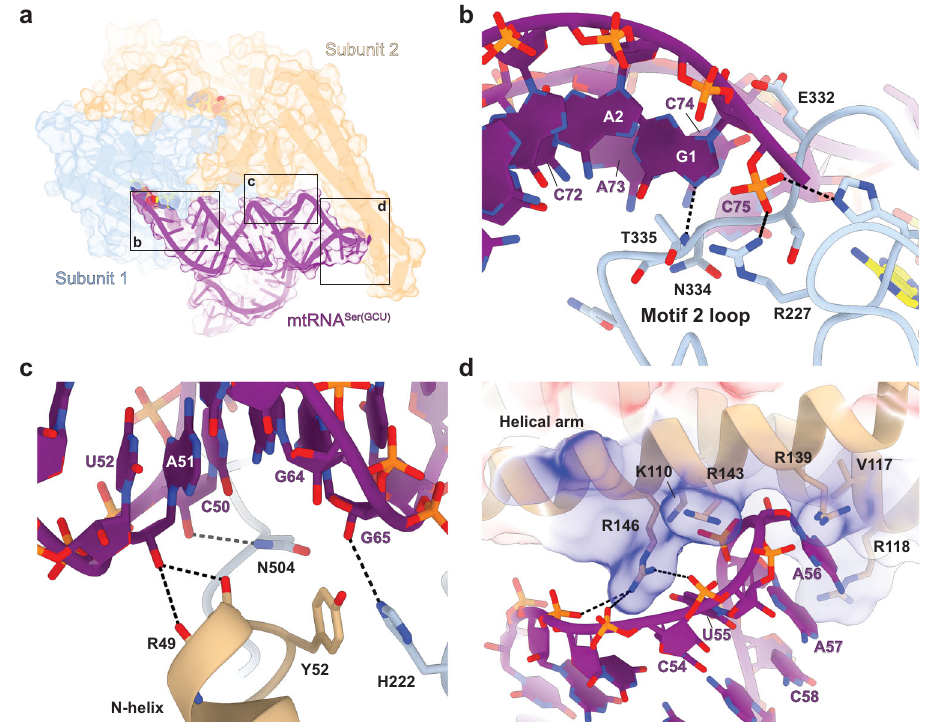
Fig. 4 | BindinginterfacesbetweenmtRNA Ser(GCU) and mSerRS. a Overview of the mSerRS-mtRNA Ser(GCU) complex with regions enlarged in b , c , and d indicated. b Close-up view of the interactions between the acceptor arm of mtRNA Ser(GCU) (purple) and the motif 2 loop (blue) at the entrance to the active site. c Close-up view of the interactions of the T-stem (purple) with the N-helix (wheat) and C-tail (blue) of mSerRS. C50 is modi fi ed to m 5 C in human mtRNA Ser(GCU)31 , with the 5-methylgrouppointingawayfromthesynthetaseinterface. d Close-upviewofthe